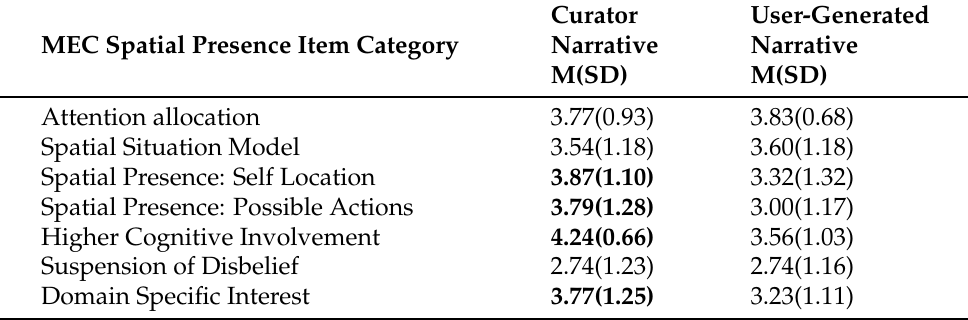
Table 1. Average MEC-SPQ (Measurements, Effects, Conditions Spatial Presence Questionnaire) scores for each construct for participants who experienced the curator narrative vs. those who experienced the user-generated narrative. In bold are the scores with at least a difference of 0.5 in comparison to the other participant